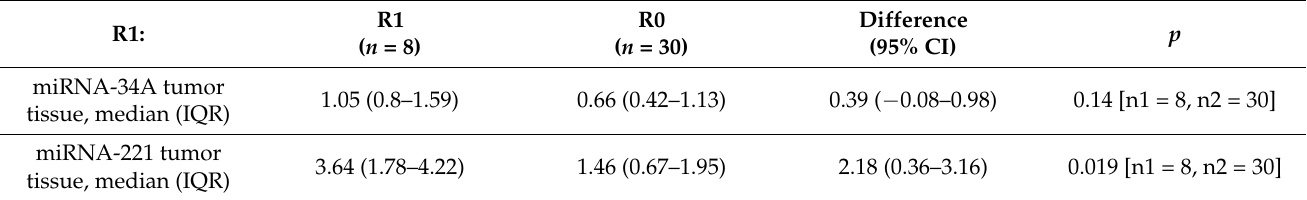
Table 4. Synthesis: miRNA-34A tumor tissue, miRNA-221 tumor tissue, depending on